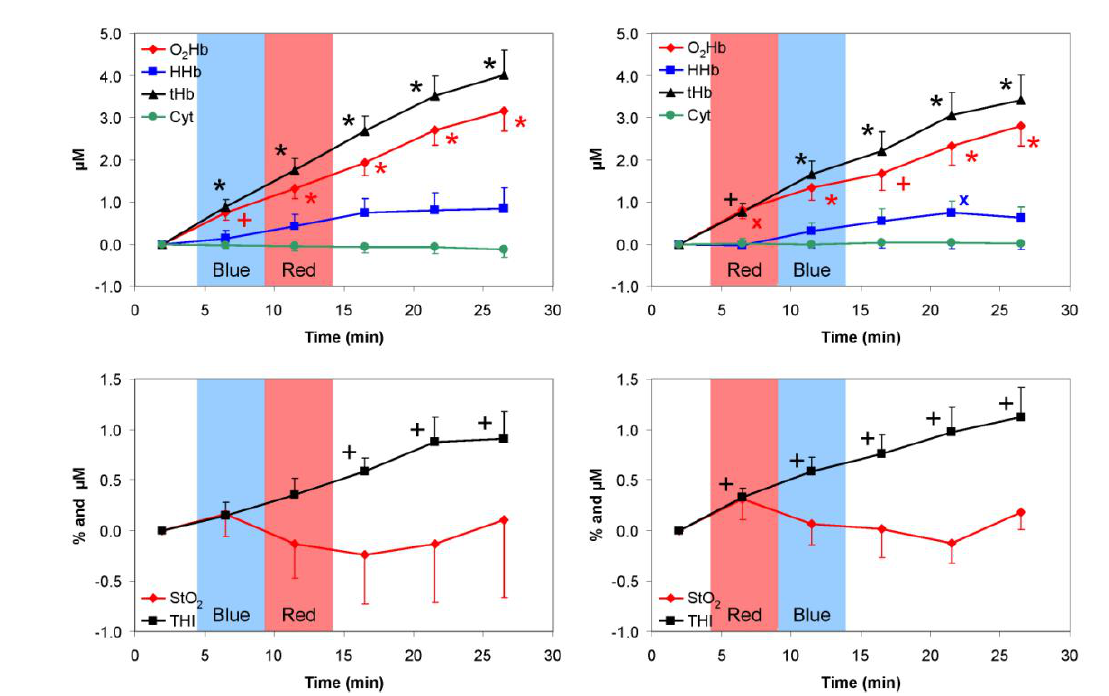
FIGURE 3. Calf muscle: time evolution of the muscle parameters. Left graphs: data from exposure to first blue and then to red light (shaded areas). Right graphs: data from exposure to first red then blue light (shaded areas). Upper graphs: NIRS parameters — O Hb = oxyhemoglobin, HHb = 2 deoxyhemoglobin, tHb = total hemoglobin, Cyt = cytochrome oxidase redox state. Lower graphs: NIRS parameters — StO = tissue oxygen saturation, THI = total hemoglobin concentration. All 2 parameters are shown relative to the baseline value before the exposure to colored light, which was set to zero. Significant changes from baseline are marked by an x for p < 0.05, + for p < 0.01, and * for p < 0.001. There were considerably larger and highly significant increases in O Hb, tHb, and 2 THI, which indicate blood pooling in the leg. The whiskers indicate the standard error of